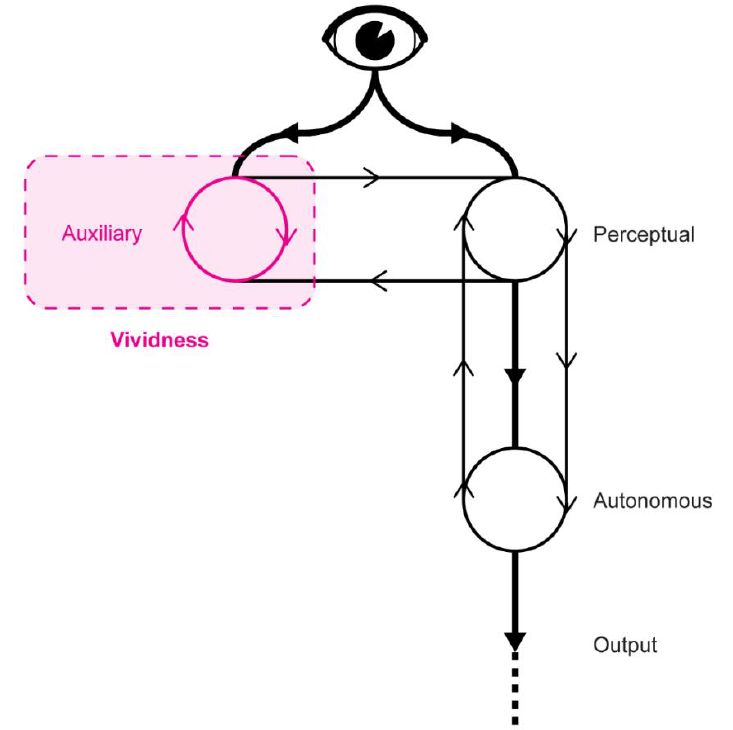
Figure 7. In neural networks, vividness could be conceived as arising from auxiliary processes that connect to perceptual conscious thinking processes. According to Aleksander [98], the exchange of neural signals between auxiliary and perceptual conscious processes has been identified as iconic transfers, and results in conscious sensory perception, or a machine gaining the ability to reflect on itself and its decisions. Figure adapted from Aleksander